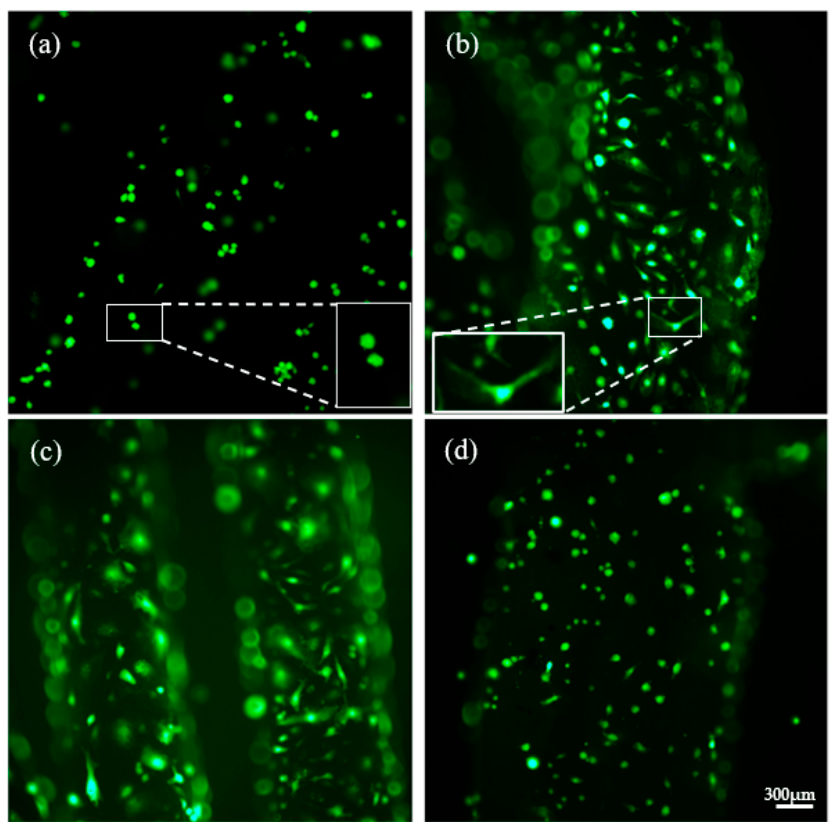
Figure 8. Analysis of the cell morphology of the ECFCs cultured on PLA disks impregnated with mango extract. Images of the ECFCs cultures on PLA disks impregnated with mango extracts under different conditions and non-impregnated control disc. The photographs were taken at 10× magnification: ( a ) PLA control; ( b ) 35 °C, 100 bar (3D + SCI); ( c ) 35 °C, 400 bar (3D + SCI); ( d ) 35 °C, 400 bar (SCI + 3D).